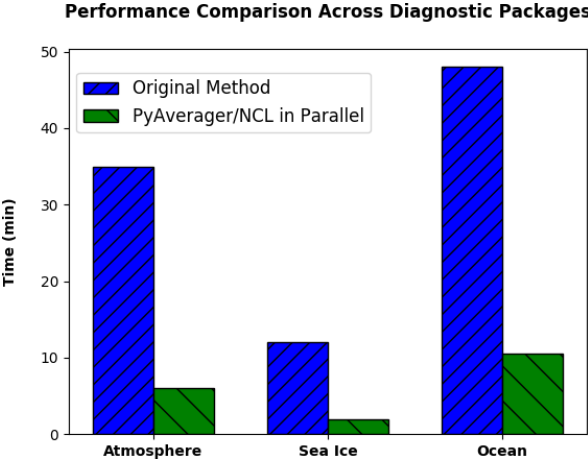
Figure 5. The performance comparison across different diagnostic packages from 10 years of monthly CESM data. These timings in- clude the total time to create all of the required climatology files and to run each of the NCL plotting scripts. The PyAverager/NCL in Parallel timings were all computed using 16 MPI